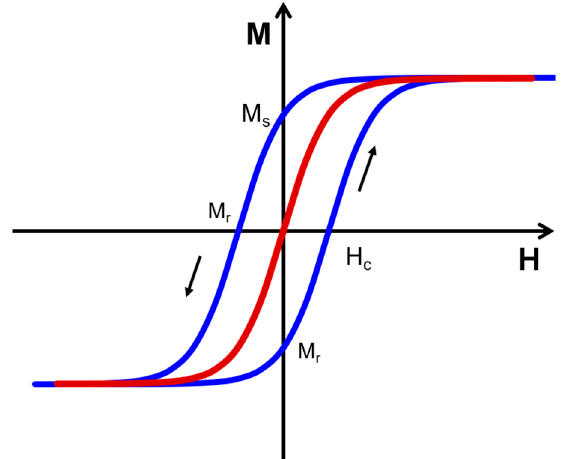
Figure 3. Schematic illustration of a magnetization hysteresis loop (blue) which shows the change in magnetization as a function of an applied magnetic field. A non-hysteretic magnetic curve (red) is representative of superparamagnetic behavior.